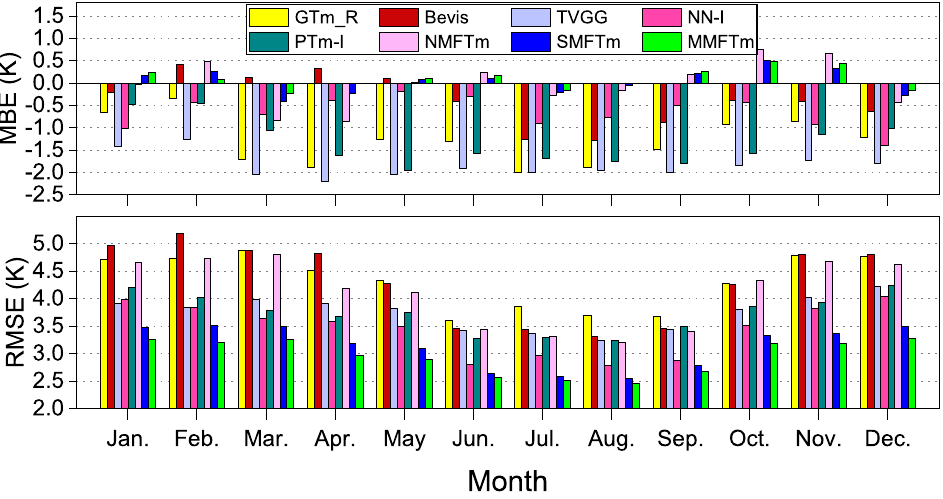
Figure 16. Results of MBE and RMSE for different models in each